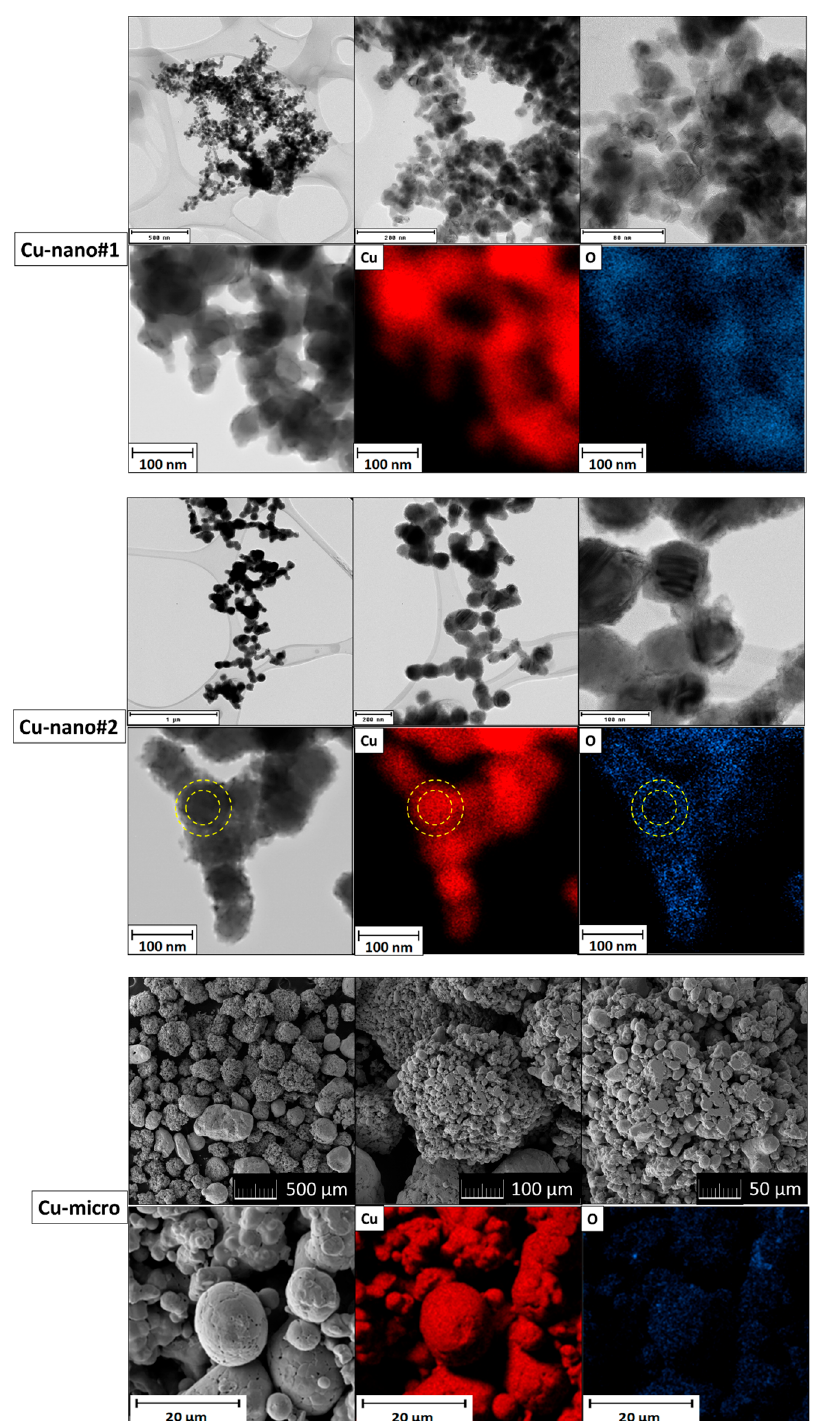
Figure 2. TEM micrographs and elemental maps for Cu-nano#1 and Cu-nano#2; SEM micrographs and elemental maps for Cu-micro.